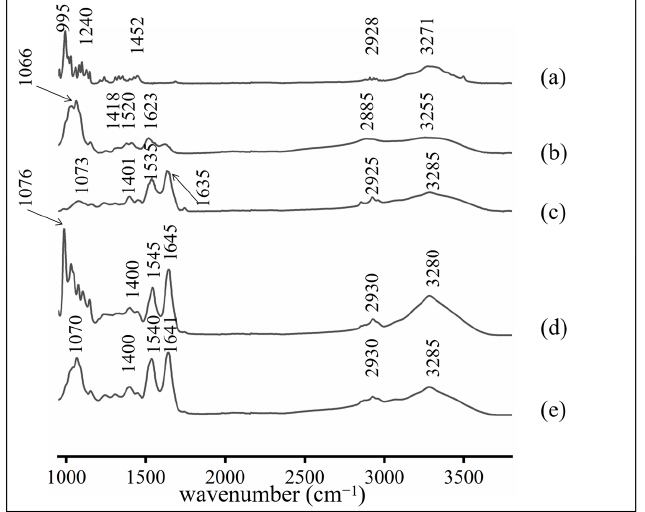
Figure 1. FTIR spectra of ( a ) trehalose, ( b ) COS, ( c ) MP, ( d ) MP + trehalose, and ( e ) MP + COS. For MP, its characteristic absorption peaks appeared at 3285 cm − 1 , 2925 cm − 1 , 1635 cm − 1 , 1535 cm − 1 , 1401 cm − 1 , and 1073 cm − 1 , corresponding to amide III O-H stretching vibration, C-H stretching vibration, carbonyl C=O double bond stretching vibration, C-N stretching, N-H bending vibration, and C-O stretching vibration, respectively